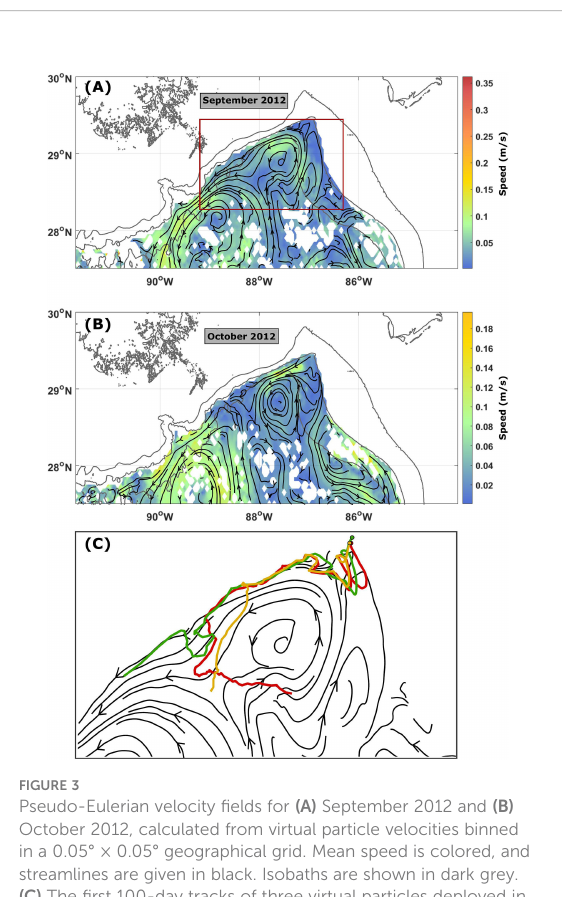
FIGURE 3 Pseudo-Eulerian velocity fi elds for (A) September 2012 and (B) October 2012, calculated from virtual particle velocities binned in a 0.05° × 0.05° geographical grid. Mean speed is colored, and streamlines are given in black. Isobaths are shown in dark grey. (C) The fi rst 100-day tracks of three virtual particles deployed in September 2012 were superimposed onto streamlines from (A) , where the red box in (A) indicates the area of (C) . Circles indicate deployment